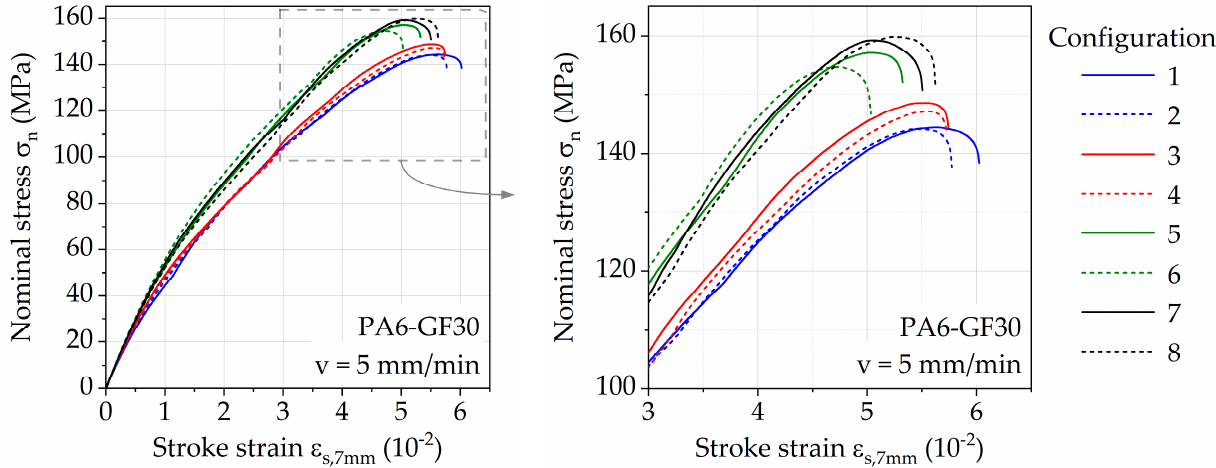
Figure 4. Exemplary stress–strain curves of PA6-GF30 for various injection molding parameter configurations.